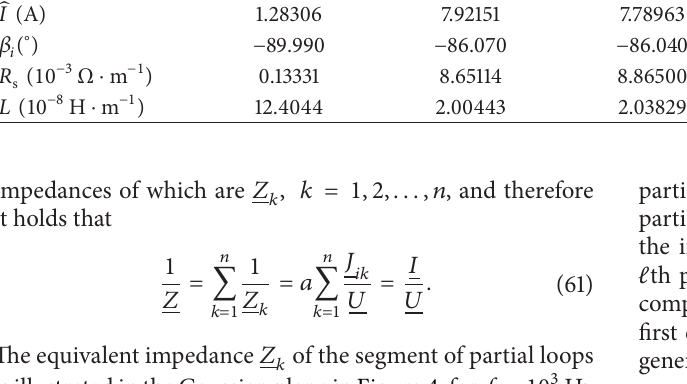
Table 2: Dependence of current in inner conductor and impedance replacing 1m of pair of conductors in Example 1 on 𝑛 , for 𝑓 = 10 6 Hz. 𝑛 1 100 500